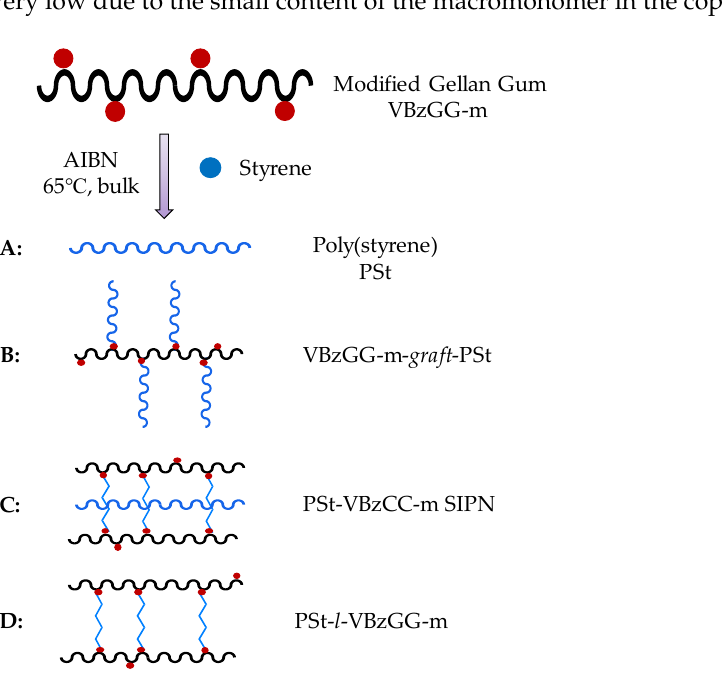
Scheme 2. Possible processes occurring during copolymerization of GG-m and styrene at 65 °C. Black line — GG, red dots — methyl styrene groups, blue dots — styrene; light blue wavy lines — PSt homopolymer and/or grafted PSt, zigzag blue lines — crosslinked PSt segments. A — St homopolymerization, B — St grafting copolymerization onto VBxGG-m, C — simultaneous St homopolymerization and St crosslinking copolymerization with VBzGG-m, D — St crosslinking copolymerization with VBzGG-m.